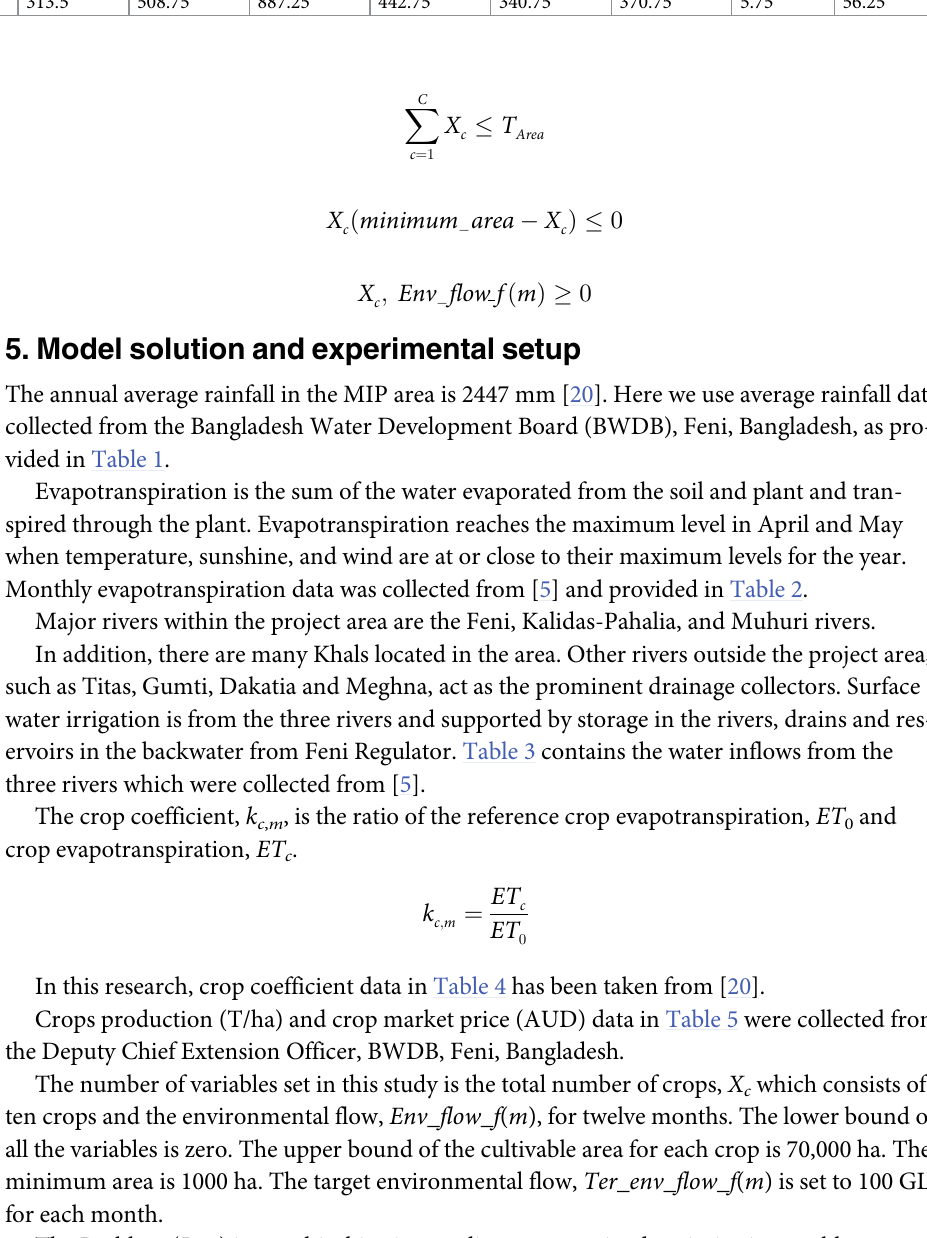
Table 1. Rainfall data (in mm) in the Muhuri irrigation area. Jan